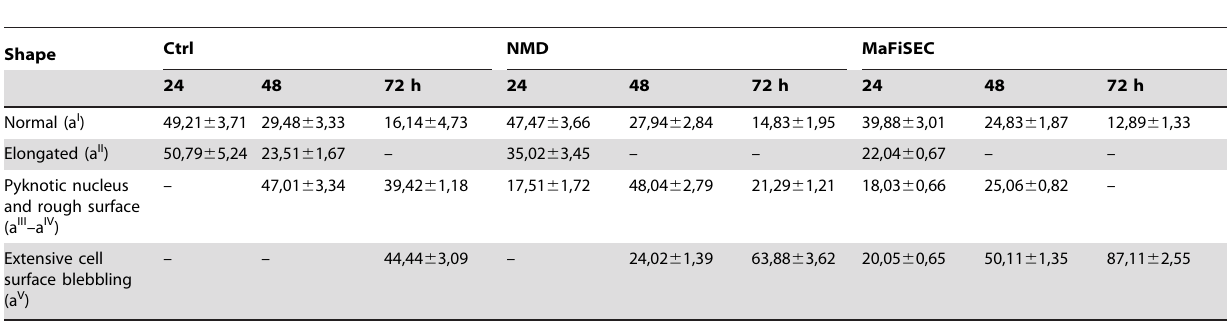
Table 1. Percentages of normal or modified morphologies of lymphocytes during 72 h of culture in absence or presence of 6 mT